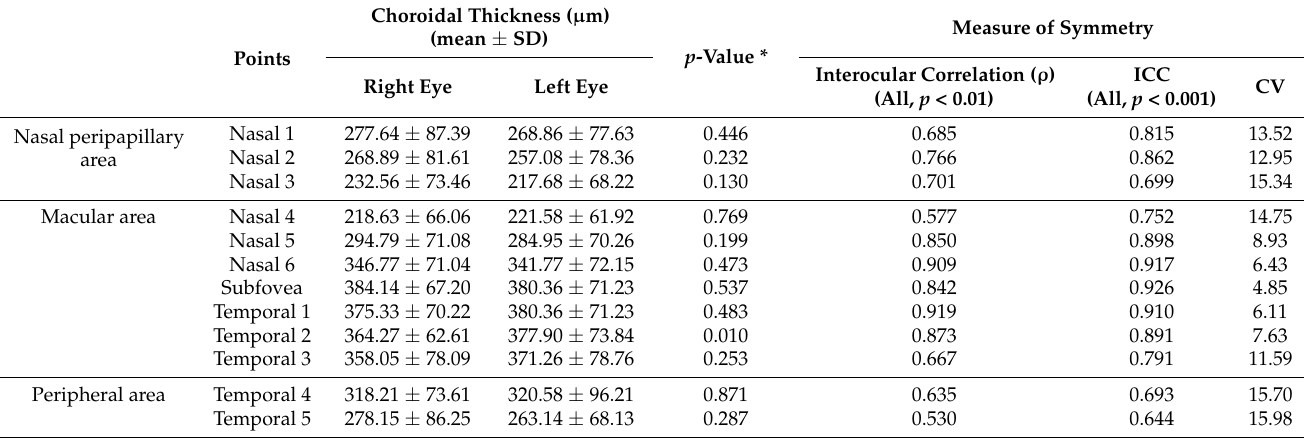
Table 2. Comparison of choroidal thickness between the right and left eyes at 12 measurement points. Choroidal Thickness (μm) Measure of Symmetry (mean ± SD) Points p -Value * Interocular ICC Right Eye Left Eye Correlation ( ρ ) CV (All, p < 0.001) (All, p < 0.01)